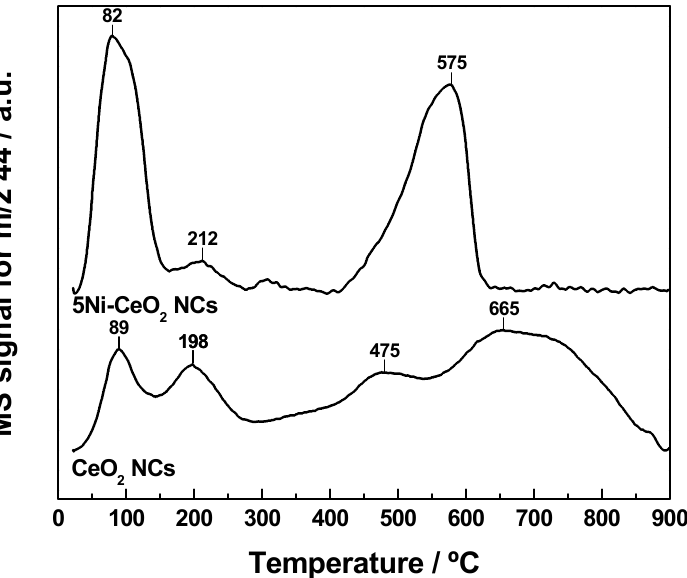
Figure 6. TPD-MS study of CO 2 ( m / z = 44) pre-adsorbed at room temperature on CeO 2 NCs and 5Ni-CeO 2 NCs sample.